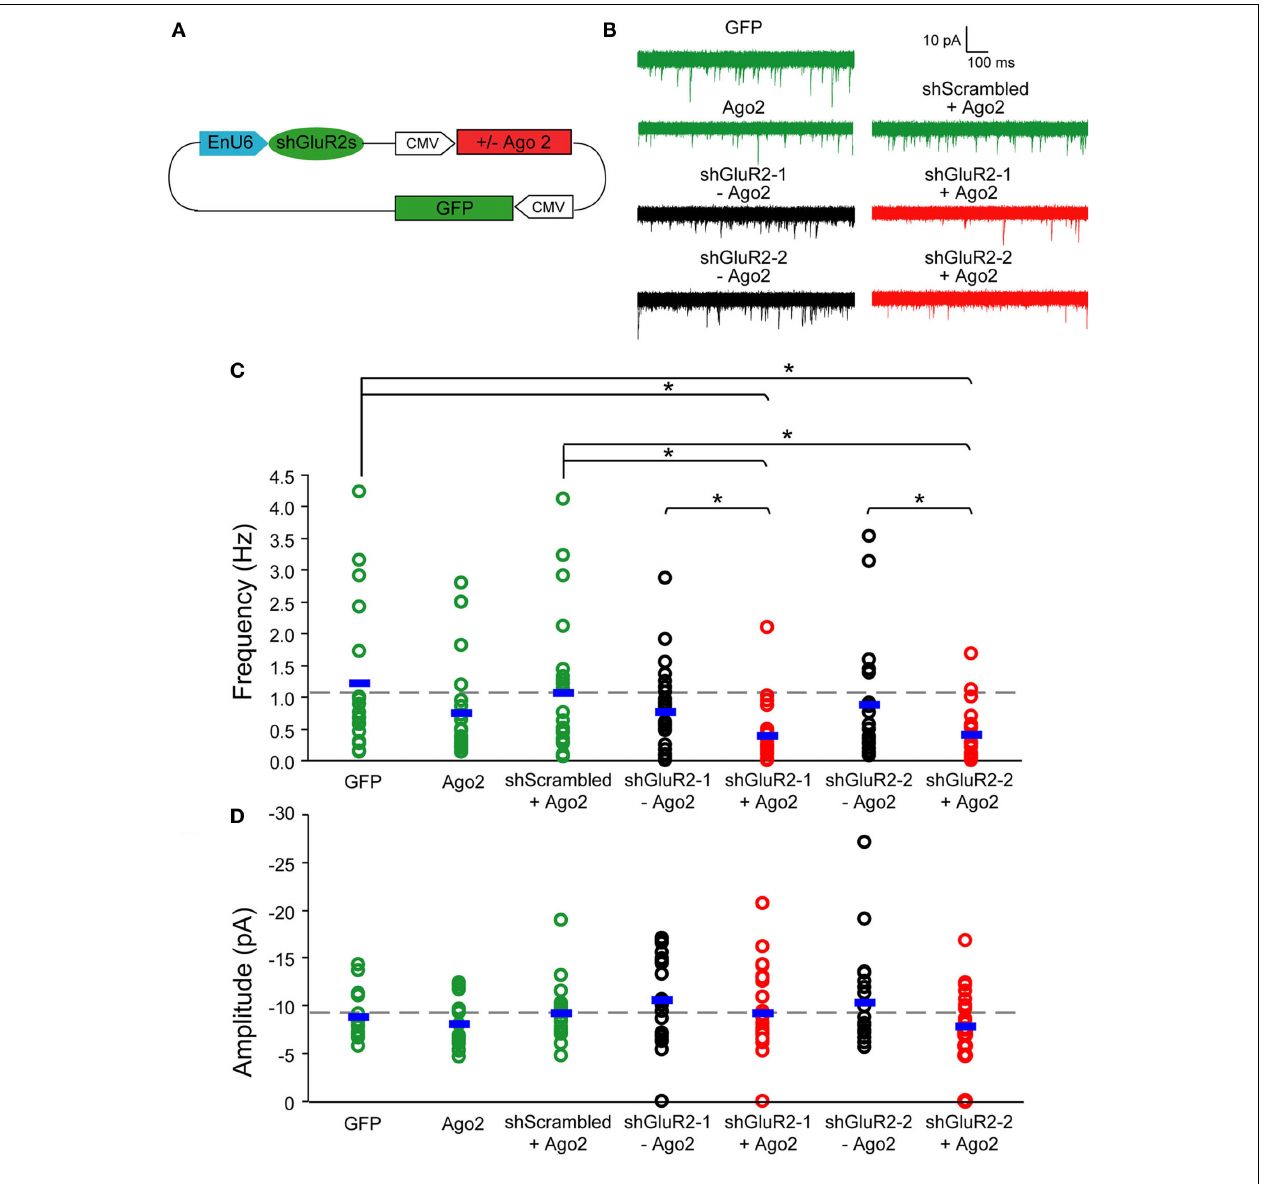
FIGURE 6 | Ago2 expression enhances RNAi reduction of AMPA receptor-mediated synaptic responses in vivo . Whole-cell recordings were made from CNS neurons of Xenopus tadpoles transfected with pSi construct expressing shRNAs targeting the GluR2 subunit of AMPA receptor with or without Ago2 co-expression. (A) Diagram of the pSi constructs containing EnU6-shGluR2s for GluR2 knockdown, Ago2 for RNAi enhancement and GFP for cell identifi cation. (B) Representative traces of spontaneous AMPA mEPSCs, superimposed from 30 consecutive traces. Cells co-expressing Ago2 with shGluR2-1 or shGluR2-2 (red) appear to have fewer mEPSCs than cells expressing shGluR2-1 or shGluR2-2 alone (black) and other control (green) traces. (C) Frequency of AMPA mEPSC in neurons transfected with pSi